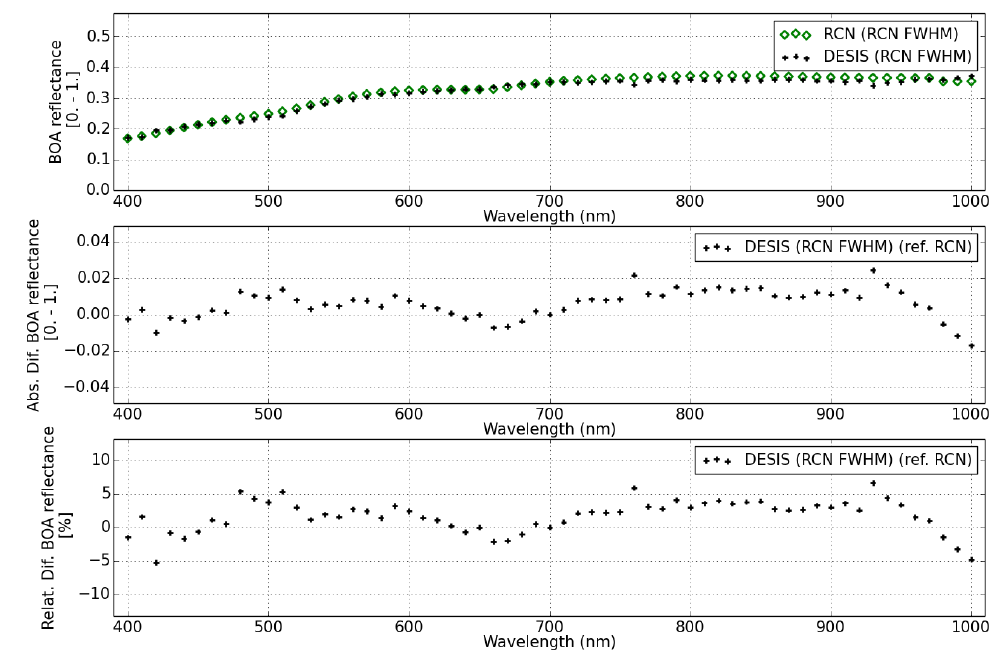
Figure 25. DESIS (black crosses) and RadCalNet (green diamonds) BOA surface reflectances at 10 nm spectral resolution for Railroad Valley Playa site (13 December 2018): ( top ) BOA surface reflectance; ( center ) absolute difference of surface reflectance; and ( bottom ) Relative difference (%) of surface